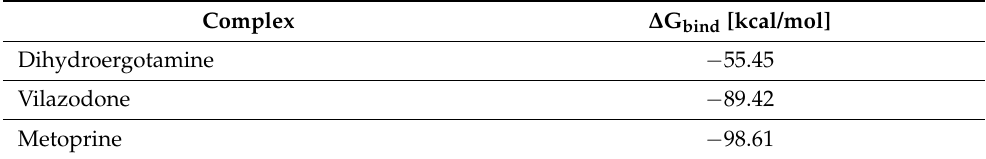
Table 2. Theoretical free energy of binding to the HNMT enzyme of dihydroergotamine, vilazodone, and metoprine obtained by MD simulations.